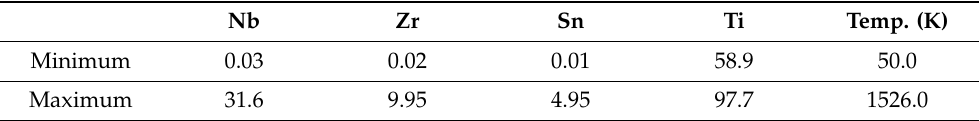
Table 1. Concentration bounds for alloying elements (atomic %) for the Ti-Nb-Zr-Sn system and temperature range (K) chosen for study. Nb Zr Sn Ti Temp. (K)